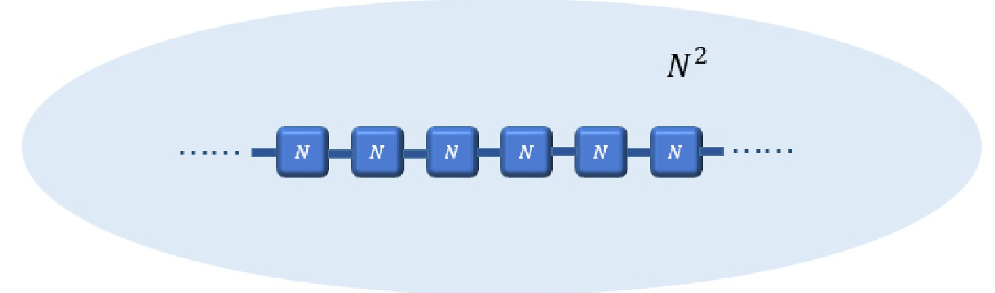
Figure 5 . A pictorial representation of the model discussed in section 3.1: an SYK chain with N fermions each site in the bath of an N 2 fermions SYK